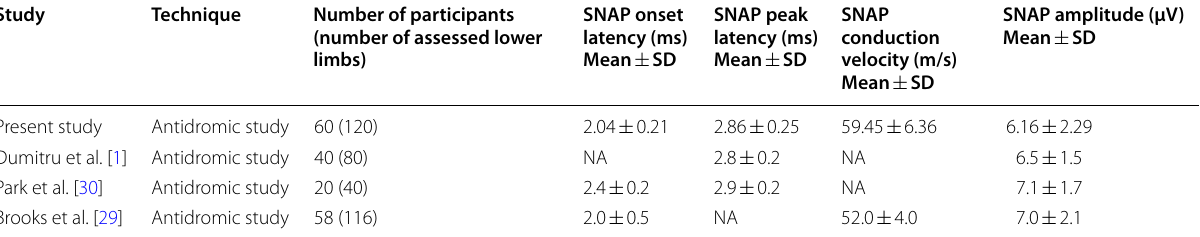
Table 8 Comparison between the present study and previous researches assessed the posterior femoral cutaneous nerve sensory conduction study [1, 29,